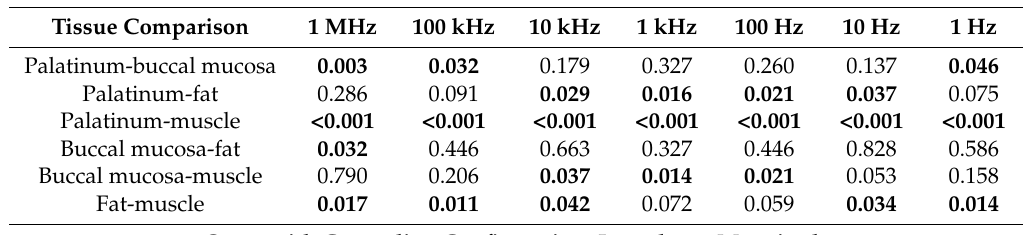
Table 3. Pairwise comparison of pork oral tissue samples. Data are based on impedance magnitude or phase values measured using the inner configuration or outer with grounding configuration for each tissue type. Pairwise difference is represented as a p -value, calculated using Dunn’s post hoc test. Significantly different pairs are